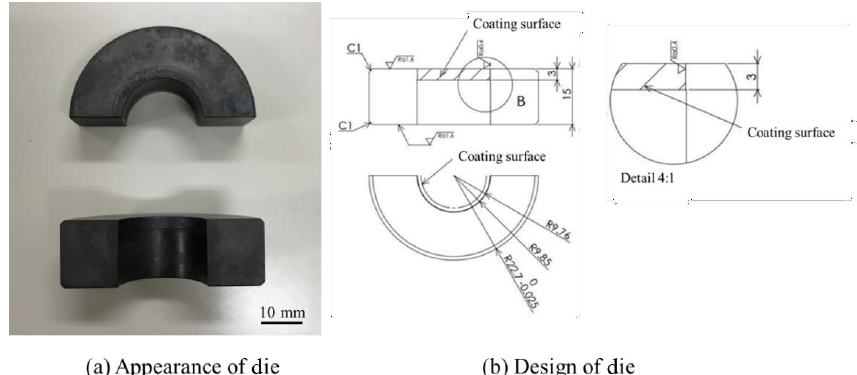
Fig. 5 Punch for forward–backward extrusion test.